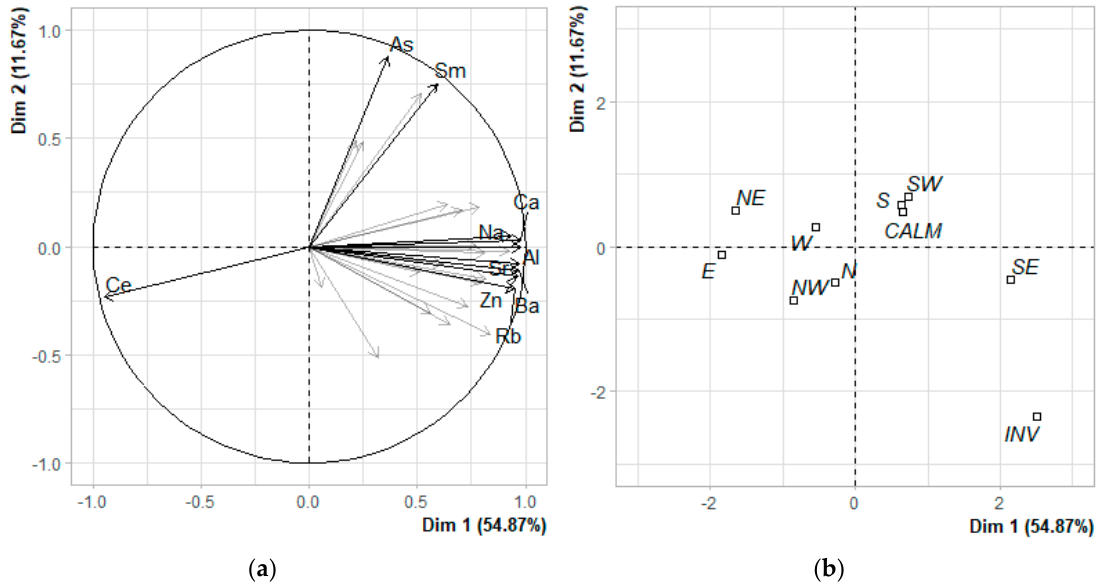
Figure 12. The cold season–PCA results for the first two dimensions; ( a ) correlation circle of clr-transformed elemental concentrations; 10 most contributing variables are presented; ( b ) qualitative factor map of the sectors.